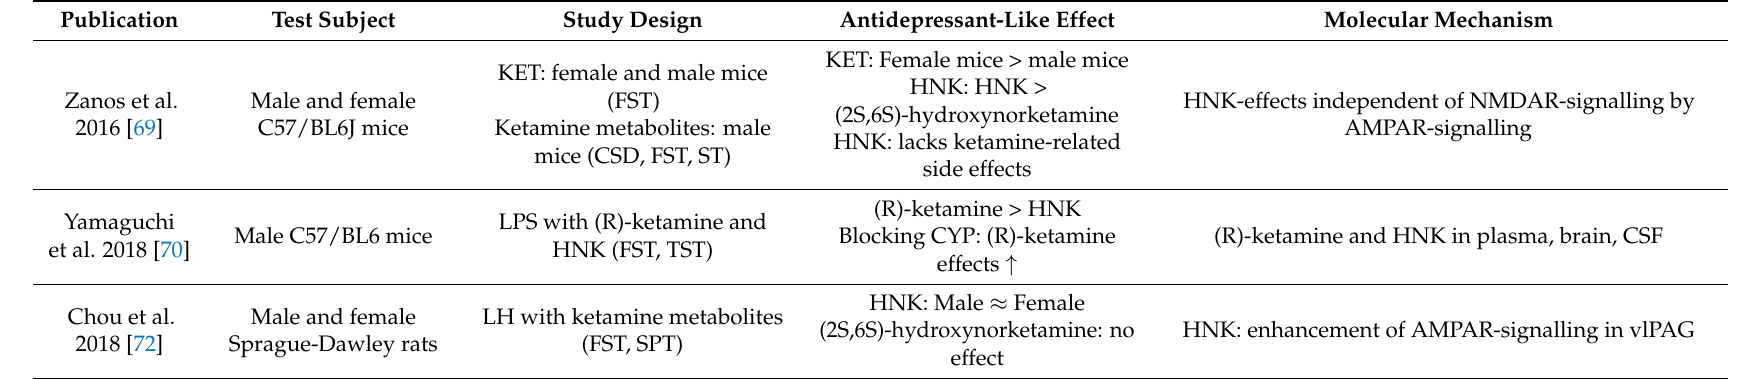
Table 2. In vitro and in vivo experiments using HNK